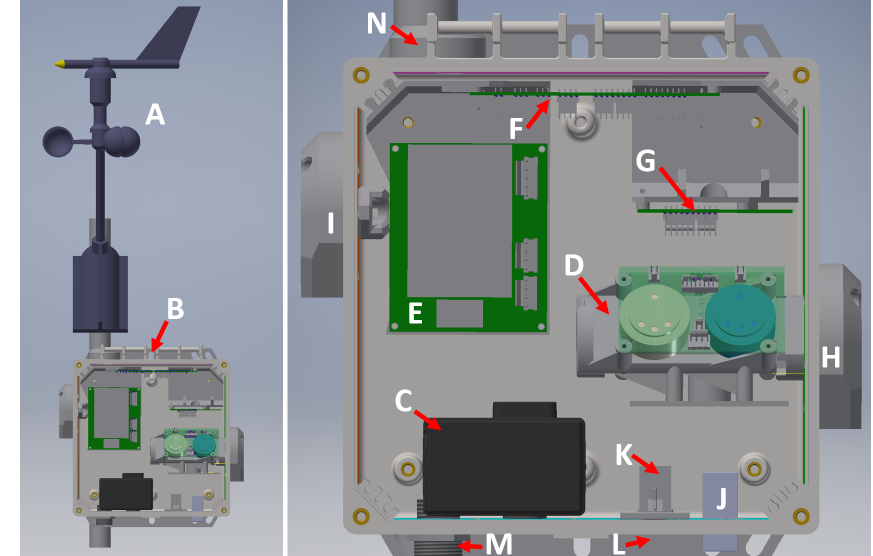
Figure 1. Mechanical drawings (wires excluded) showing the main components of the ARISense system. Each system includes an anemome- ter (A) mounted to the back bracket of the NEMA enclosure providing a description of the wind fields in the immediate proximity to the gas and particle sampling inlets of the system. Mounting brackets for wall or pole-mount configurations attach at position (B). Expanded view of the internal components reveals the optical particle counter (C), gas sampling manifold (D) with embedded electrochemical and NDIR and RH/ T sensors, transformer/power PCB (E), main controller PCB (side view) (F), communication PCB for ethernet connectivity (G), gas sampling inlet and exhaust rain hoods (H, I), RJ11 and RJ45 connections for anemometer data and CAT-5 connectivity (J, K), microphone as- sembly (L), weather tight AC power input (M), and solar sensor assembly for light intensity measurement (N). The 3-D-printed parts include the gas sampling manifold, rain hoods, exhaust and microphone mounting bracket, solar sensor interface, and PCB mounting scaffold. As described in the text, the gas and particle sampling inlets are separate, with the OPC-N2 sampling through the bottom face of the enclosure to protect from liquid water